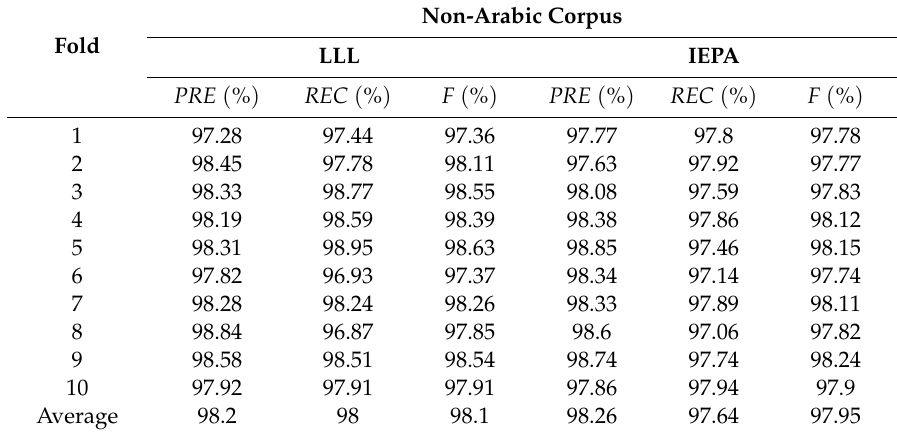
Table A7. Performance evaluation of ontology learning using the proposed G-WOA and the non-Arabic